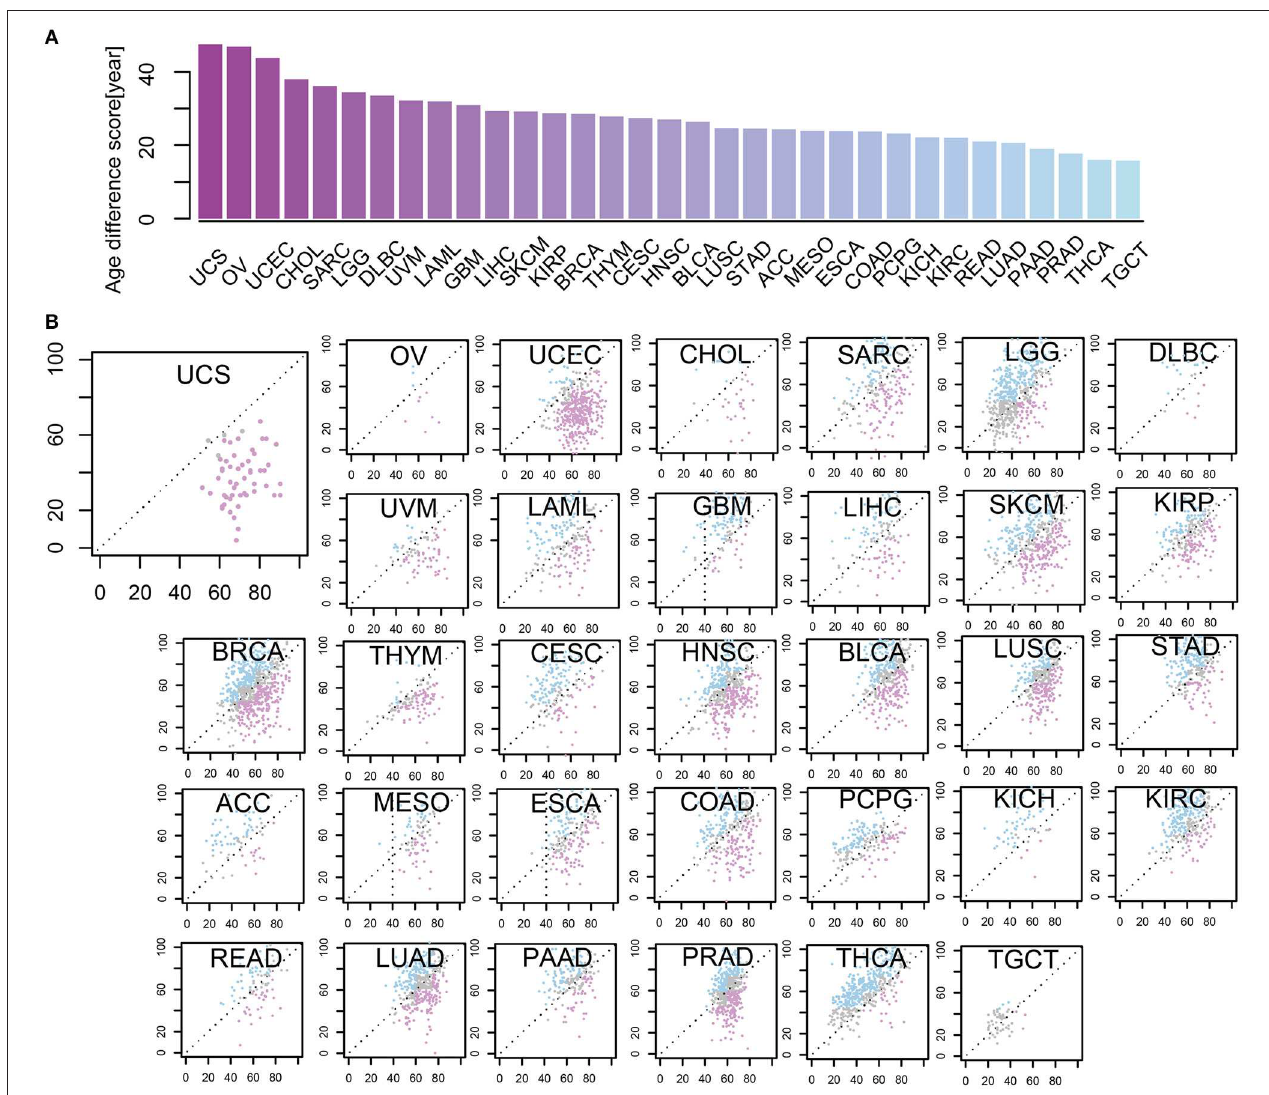
FIGURE 4 | The levels of some methylation sites were differential in age-related cancer samples between m-age and chronological age. (A) Age different scores between chronological age and predicted m-age among 33 cancer types. (B) The relationship between chronological age and predicted m-age for all the 33 disease types. Compared to the chronological age group, the pink color indicates that the predicted m-age group was down-regulated, the blue color indicates that the predicted m-age group was up-regulated, and the gray color indicates that the predicted m-age group remained